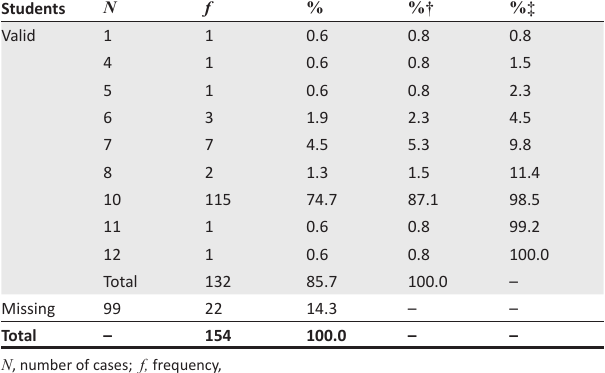
TABLE 4: Students’ performances on post-test HIV counselling.